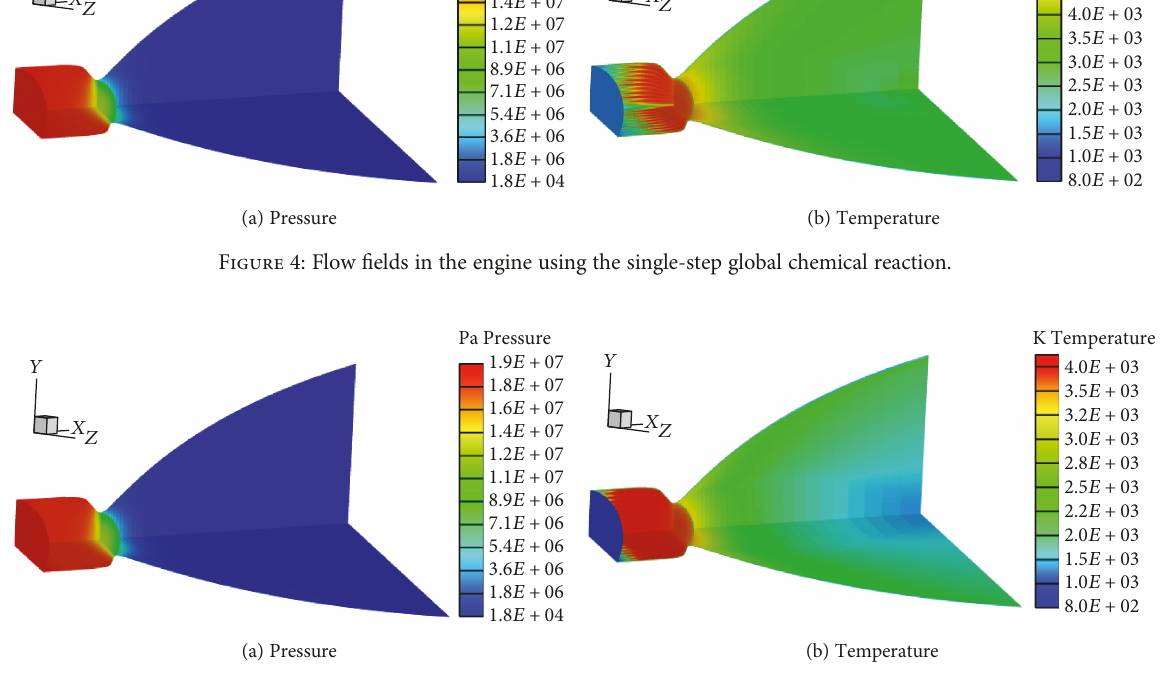
Figure 5: Flow fi elds in the engine using the multistep chemical reaction.